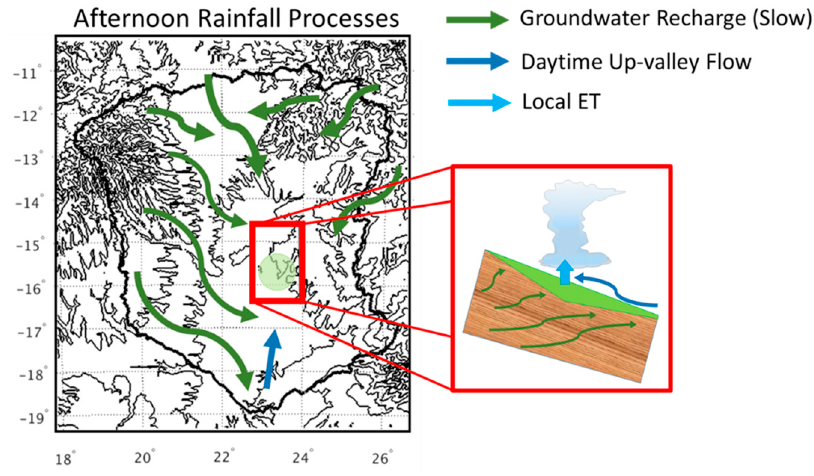
Figure 14. Conceptual representation of land–atmosphere interactions driving the rainfall observed during the afternoon around the midland wetlands. during the afternoon around the midland